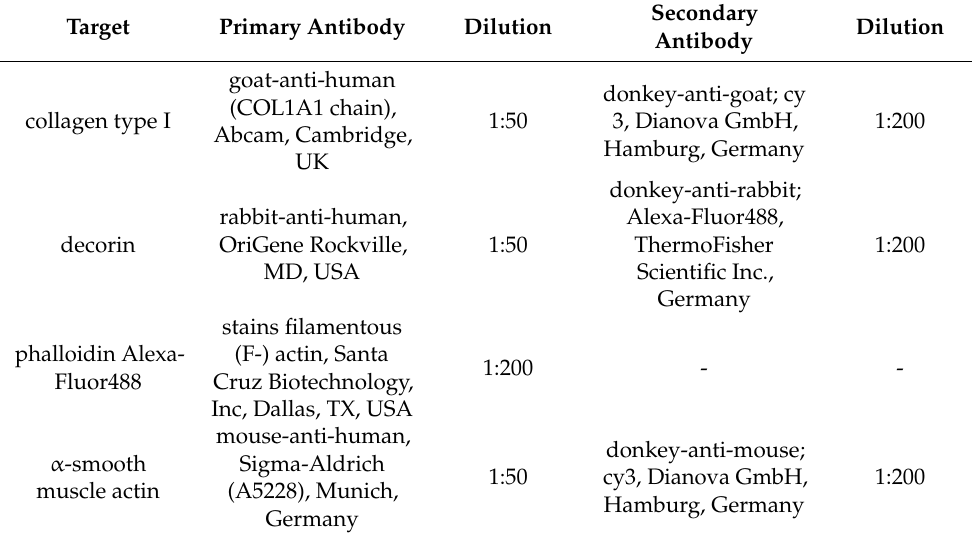
Table 3. Antibodies and staining used to assess protein expression in cell